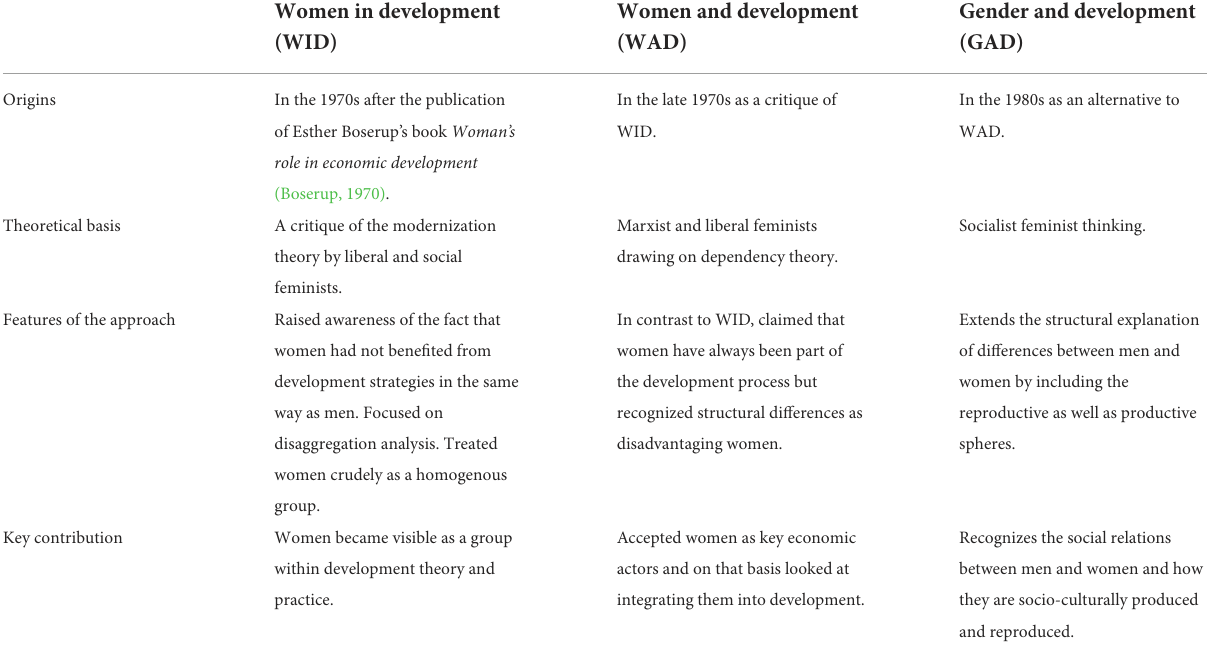
TABLE 1 Evolution in approaches to women and gender in